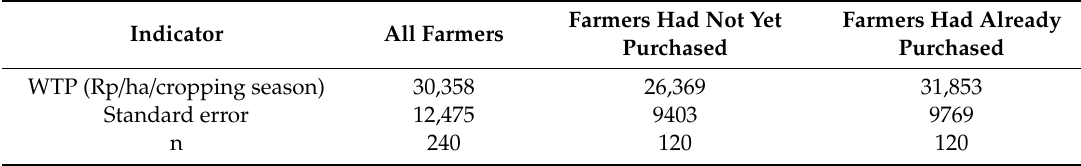
Table 7. Mean value of WTP